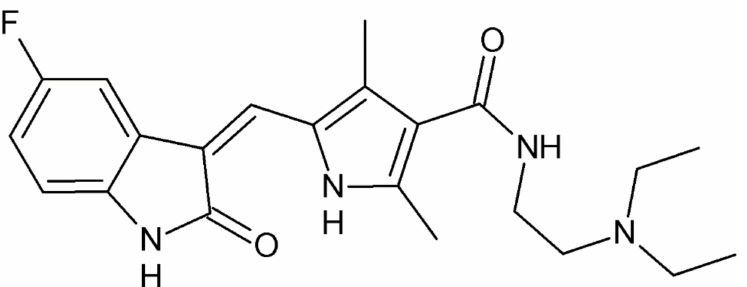
Figure 1. Structure of Sunitinib (Sun). IUPAC name: N -[2-(diethylamino)ethyl]-5-[(Z)-(5-fluoro-1,2-